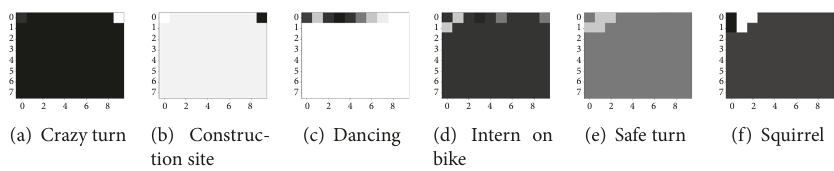
Figure 21: Representation in GU Units (Layer 3, Frame 10) ( 6